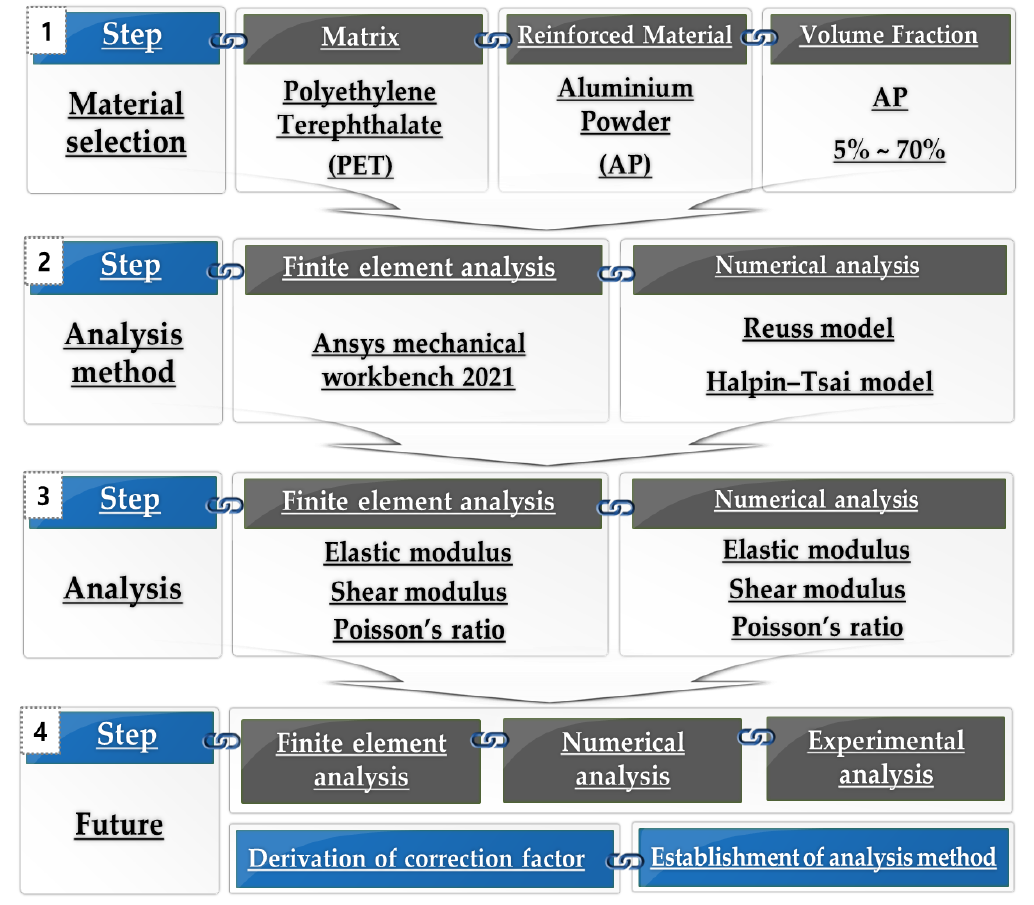
Figure 1. Flow chart for this study.